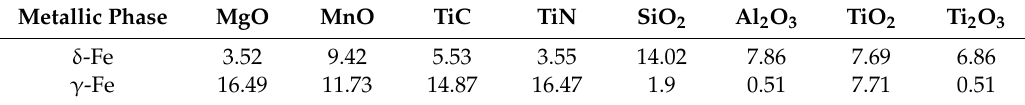
Table 4. Planar distregistry between substrates and metallic phase,